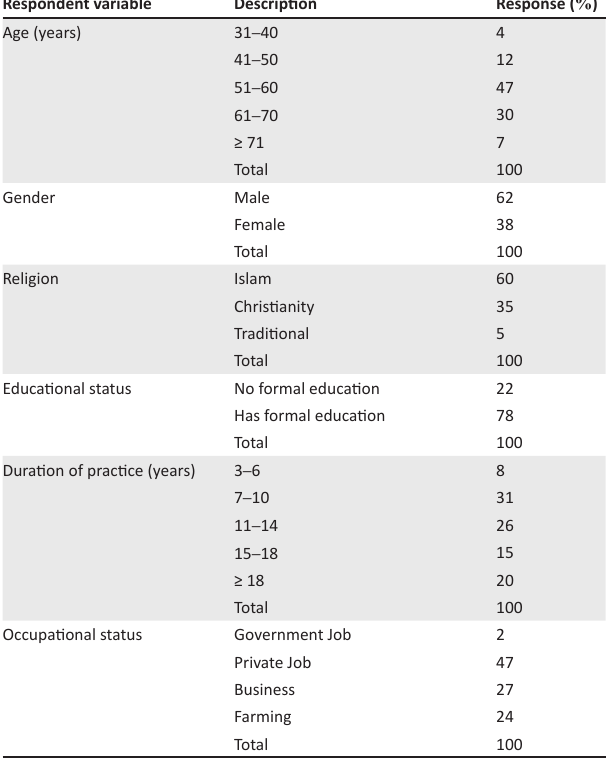
TABLE 1: Demographic characteristics of the traditional